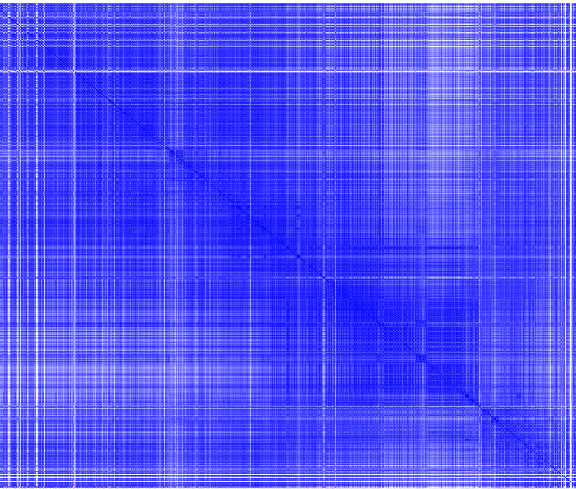
Figure 1. Visualization of the correlation